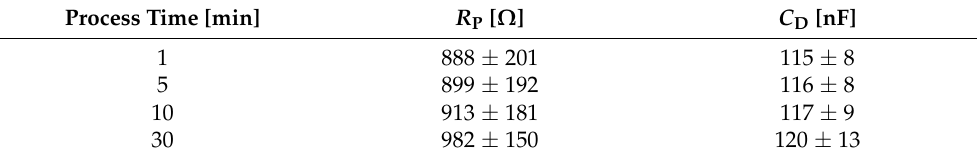
Table 2. Experimentally investigated values of R P and C D for immersion-based anodization.